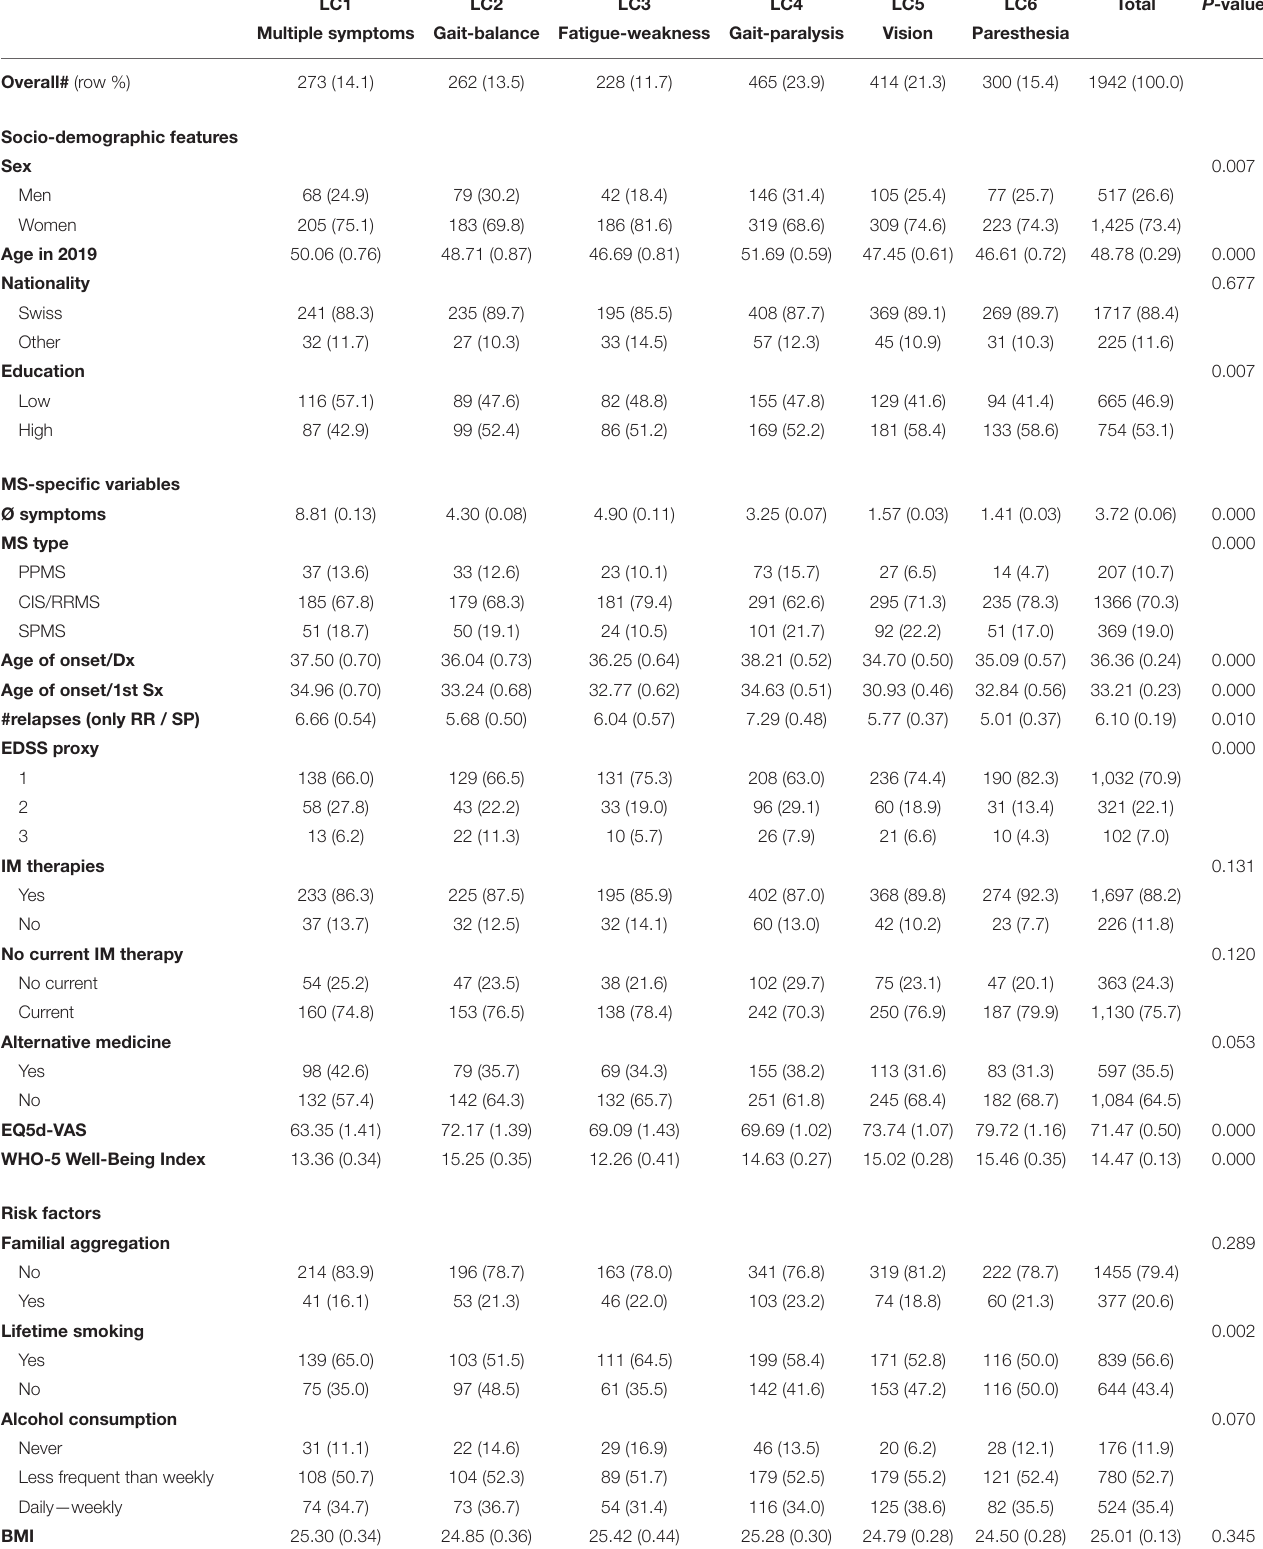
TABLE 2 | Latent classes based on MS onset symptoms: socio-demographic features, MS-specific variables and risk factors, frequencies with column % (except overall #)/proportions and means (SE); p -values related to χ 2 -test and to ANOVA,